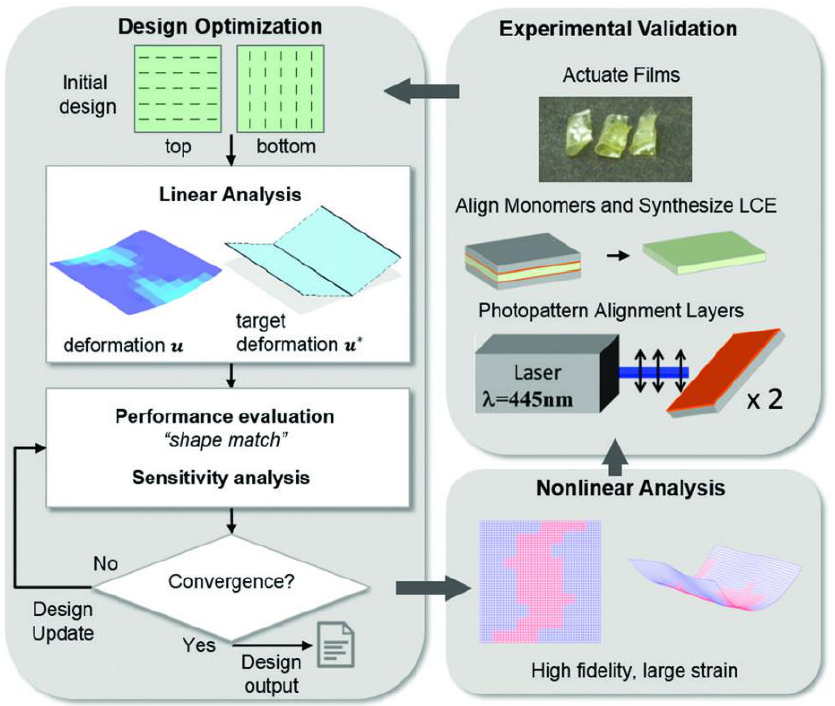
Figure 8. Outline of the design and experiment process outlined in [60] (Reprinted with permission from [57]).